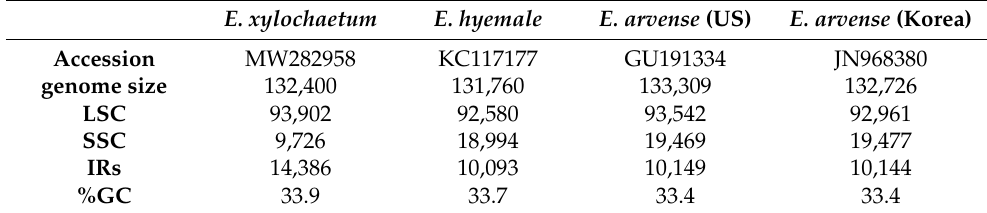
Table 1. Comparison of general characters of Equisetum plastid